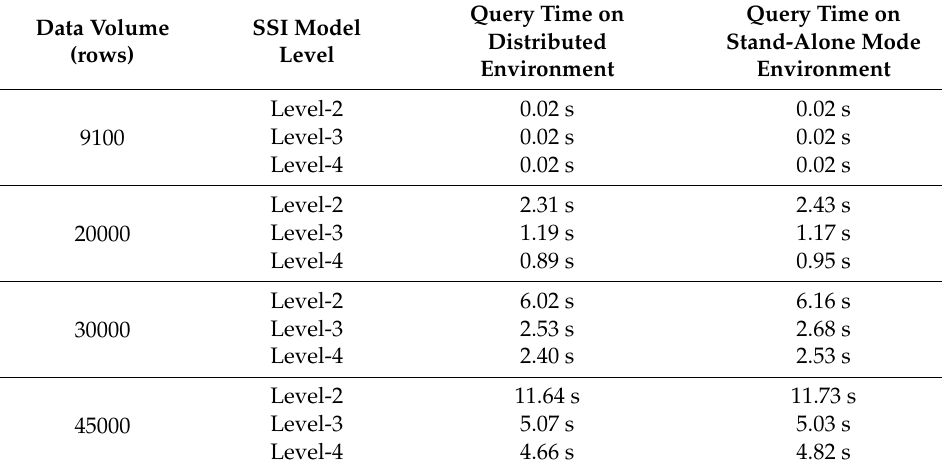
Table 3. The result of retrieval